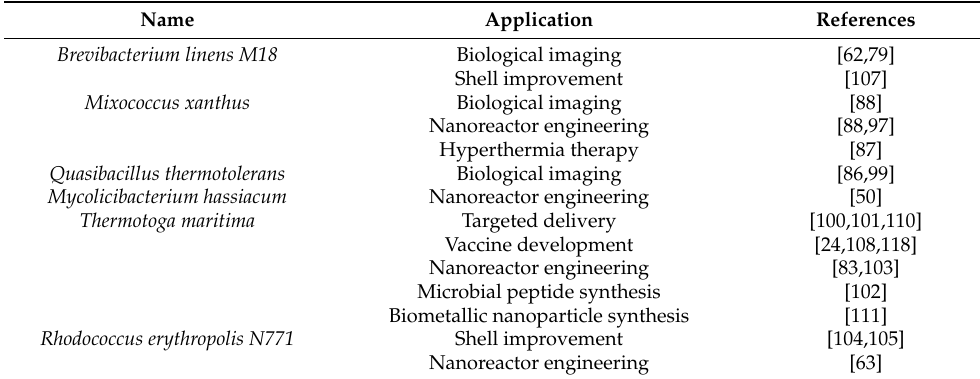
Table 1. Encapsulin systems used for biotechnological